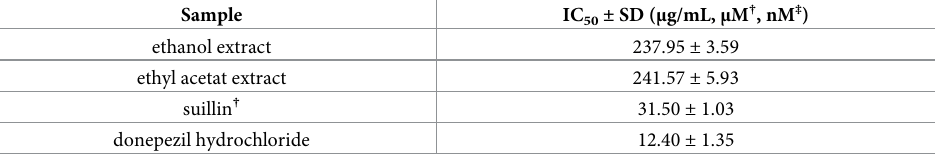
Table 1. Half inhibitory concentrations of extracts and the major isolated compound suillin as inhibitors of AChE enzyme.